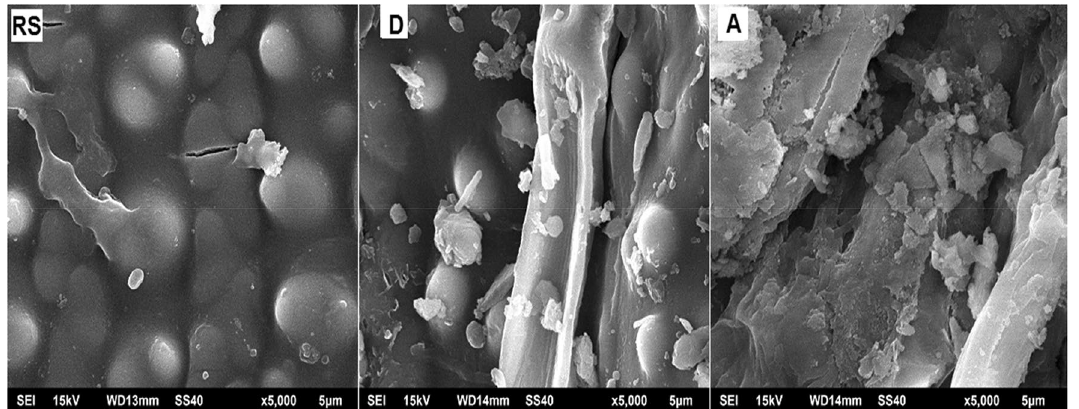
Figure 1. Scanning electron micrograph of native ( RS ), distilled water pretreated ( D ) and PWW pretreated ( A ) rice